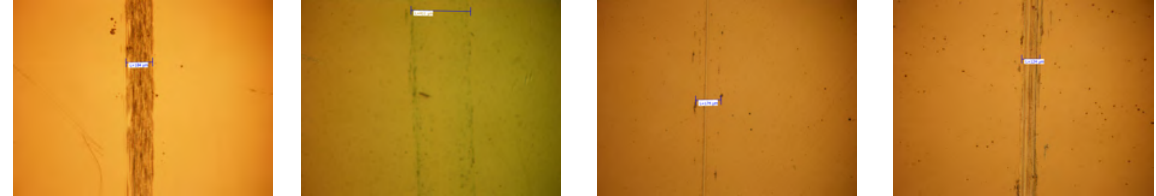
Figure 1. From left wearability of the Ti6Al4V substrate and samples Ti:DLC7(pure DLC), Ti:DLC10 (5 at.% Ti) and Ti:DLC12(25 at.% Ti). The figures are captured at magnification 200x.